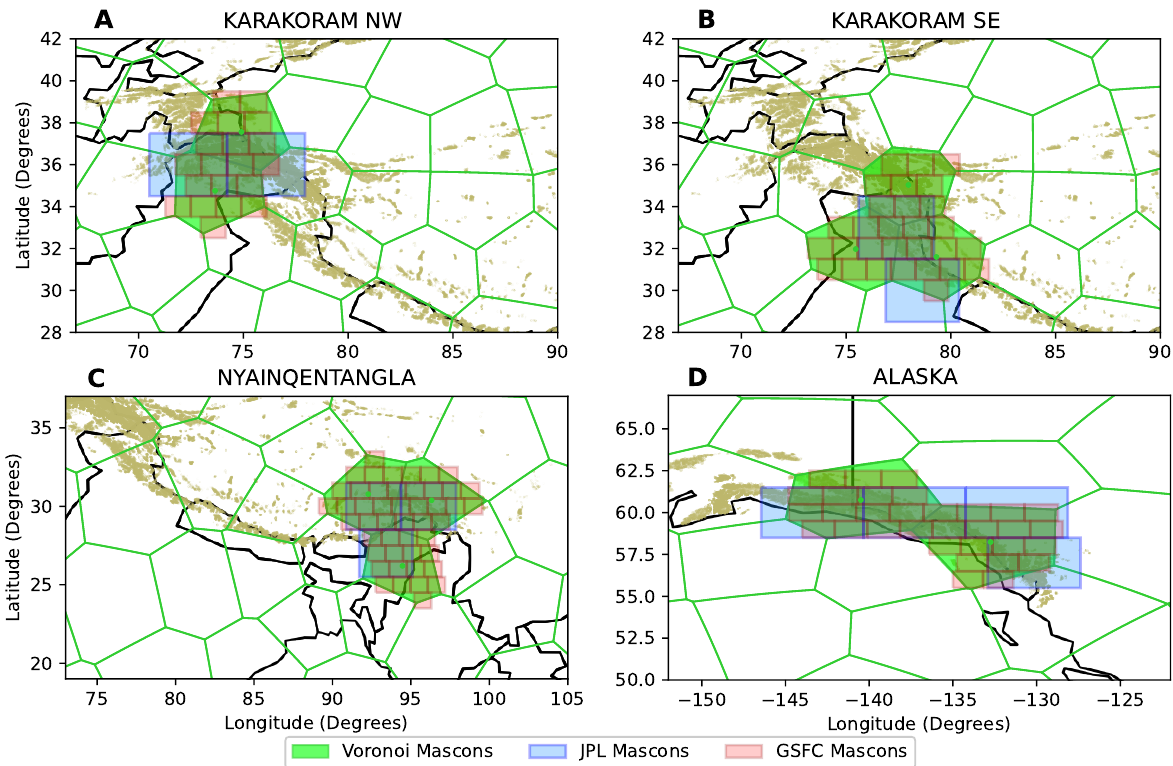
Figure 4. Our Voronoi mascon configuration (green), compared with the corresponding JPL (blue) and GSFC (red) mascons for the four case-study regions: northwest Karakoram ( A ), southeast Karakoram ( B ), Nyainqentangla ( C ), and Alaska ( D ).The green dots represent the centroids of the Voronoi mascons. The glacierized regions from the Randolph Glacier Inventory (RGI) [39] are shown in